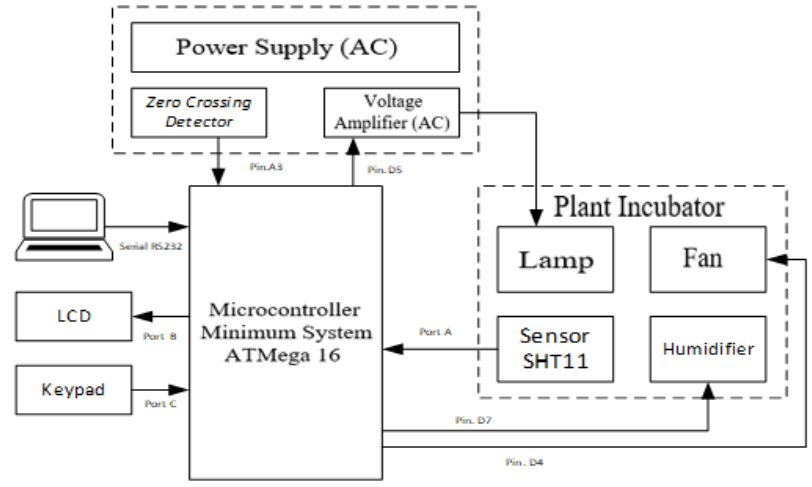
Figure 3. Diagram block of system control design.